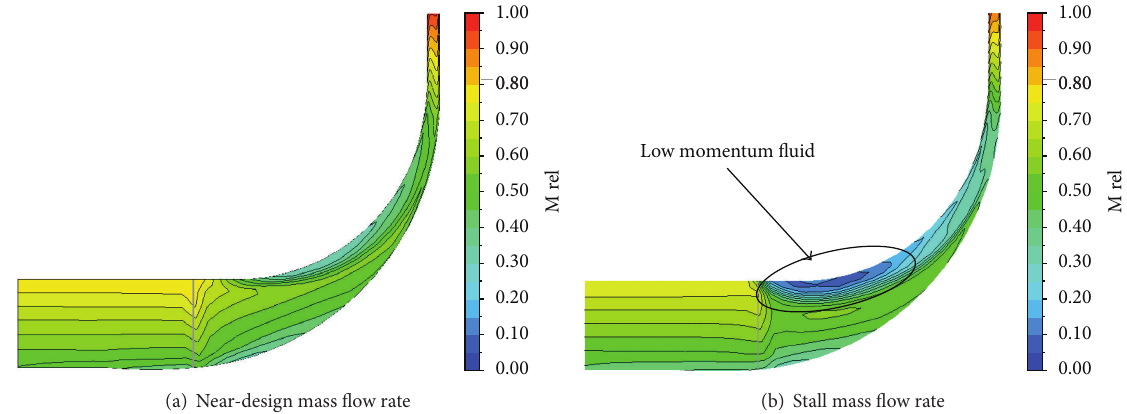
Figure 13: Circumferentially mass averaged relative Mach number distribution in impeller blade